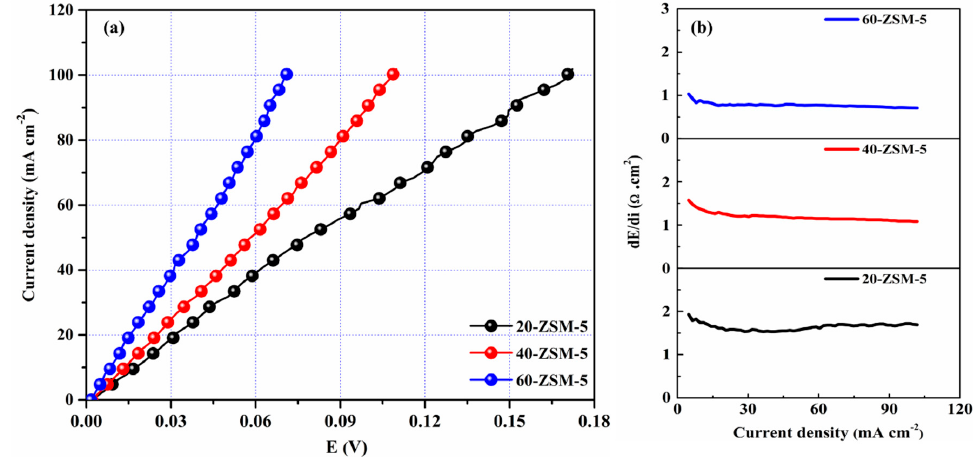
Figure 7. ( a ) Current-voltage curves, and ( b ) membrane resistance of representative’s membranes.